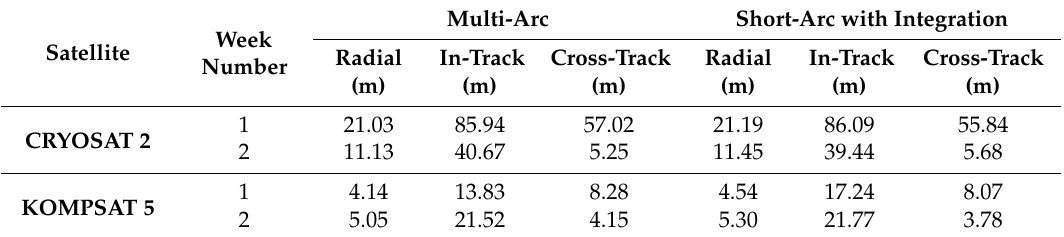
Table 5. Post-fit residuals (meter) with reference of multi-arc and short-arc batch least-squares (BLS) orbit estimation results for CRYOSAT 2 and KOMPSAT 5. The references are CPF and onboard GPS data for CRYOSAT 2 and KOMPSAT 5, respectively. The post-fit residuals for short-arc BLS orbit estimation were calculated with propagation from the epoch for each short arc to the epoch of the next short